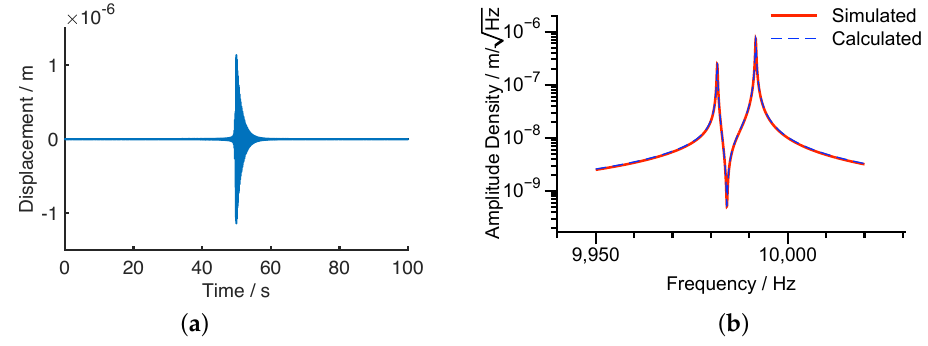
Figure 8. The responses of the resonator under the chirp excitation with A = 0.1V, V d = 5V, η f = 1 × 10 − 7 N/V 2 . ( a ) Time domain. ( b ) Frequency